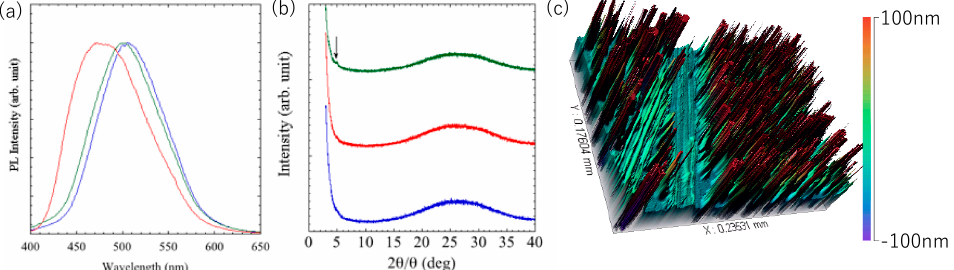
Figure 7. ( a ) Change in PL spectrum ( b ) and XRD pattern of 2ECh dispersed in PMMA (1:1 ( w / w )). Color of the spectrum indicates the film before grinding (blue), after grinding (red) and annealing (green) respectively. ( c ) Surface profile of the composite layer. The black arrow in ( b ) indicates the diffraction of 2ECh crystal (see Figure 5b).